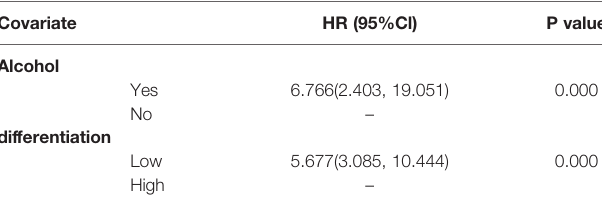
TABLE 5 | Multivariable Cox proportional hazard models of